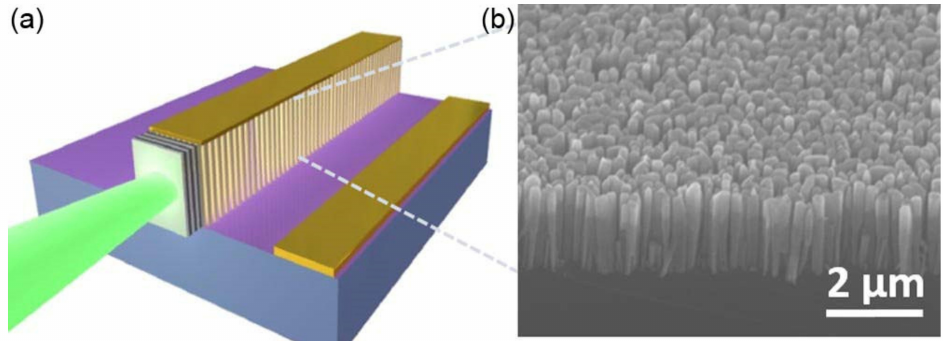
Figure 17. ( a ) Schematic of the nanowire laser structure. ( b ) SEM image of the disk-in-nanowire laser. Reproduced from [144], with permission from Copyright American Chemical Society, 2014.